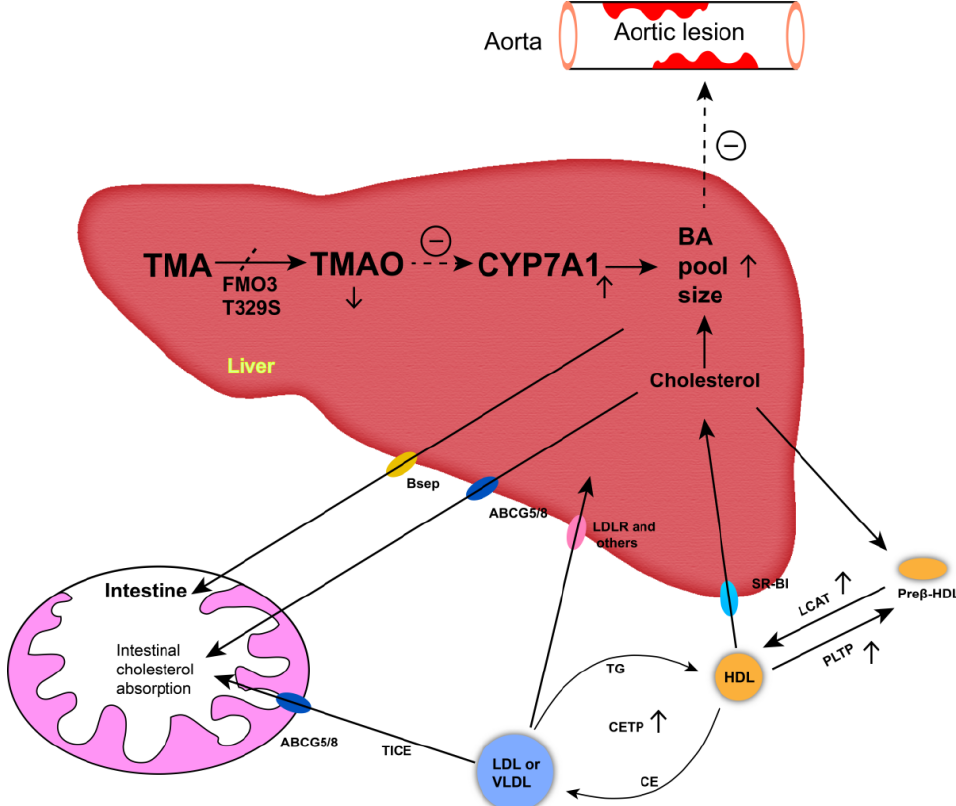
Figure 4. Schematic representation of pathways of the T329S mutation in flavin-containing monooxygenase 3 (FMO3) associated with the metabolic characteristics in chickens. Black arrows indicate movement of TMA/TMAO and cholesterol through the body. Blunt-end arrows indicate activation (+) or inhibition (−) of specified receptors and transporters or pathways. An increased bile acid pool size can alleviate the development of aortic lesions ( ㊀ ). Mutation T329S diminishes the ability of FMO3 to oxidize trimethylamine (TMA) to trimethylamine N-oxide (TMAO) and decreases the circulating TMAO levels ( ↓ ), thus decreasing the inhibition of cholesterol 7 α -hydroxylase (CYP7A1) expression ( ↑ ), accordingly. The upregulation of rate-limiting enzyme increases the levels of bile acid (BA, ↑ ). The preferential precursor for BA biosynthesis is high-density lipoprotein cholesterol (HDL-C). HDL-C needs to be delivered to hepatocytes by high-density lipoprotein (HDL) particles. The formation of mature HDL requires the action of phospholipid transfer protein (PLTP) and lecithin: cholesterol acyltransferase (LCAT). HDL cholesterol esters can be transferred to very low density lipoprotein (VLDL) or low-density lipoprotein (LDL) by the cholesteryl ester transfer protein (CETP) and be returned to the liver through the low-density lipoprotein receptor (LDLR) or other LDL and VLDL receptors. Pre β -HDL, pre β -high-density lipoprotein particles; SR-BI, scavenger receptor class B type I; ABCG5/G8, ATP binding cassette transporters G5 and G8; Bsep, bile salt export pump; TICE, trans-intestinal cholesterol export route—promotes the flow of cholesterol from plasma to enterocytes and the intestinal lumen.